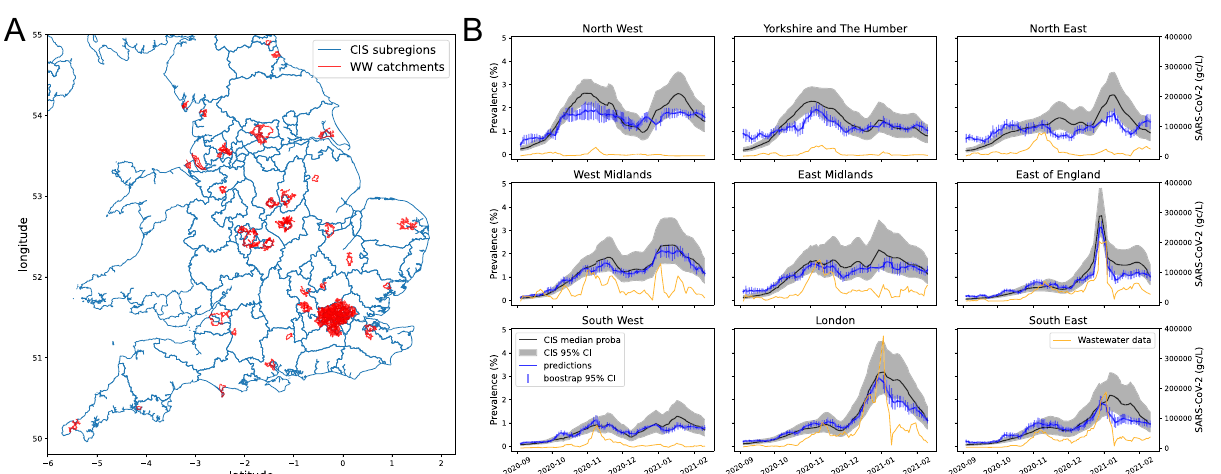
Fig. 1 Geographical summary of the data used to estimate SARS-CoV-2 from wastewater. A Map of Coronavirus Infection Survey (CIS) regions (outlined in blue) and the locations of wastewater (WW) catchments used in this study (in red). B Regional 7-day rolling averages (median) of CIS prevalence estimates (black) with 95% credible intervals using Bayesian modelling (grey regions), with corresponding predictions of prevalence from WW data only (blue) with 95% con fi dence interval from bootstrapping (blue vertical lines), and raw SARS-CoV-2 concentrations (yellow, right axis). The WW prevalence estimates are provided at a sub-regional level and combined to produce regional estimates for